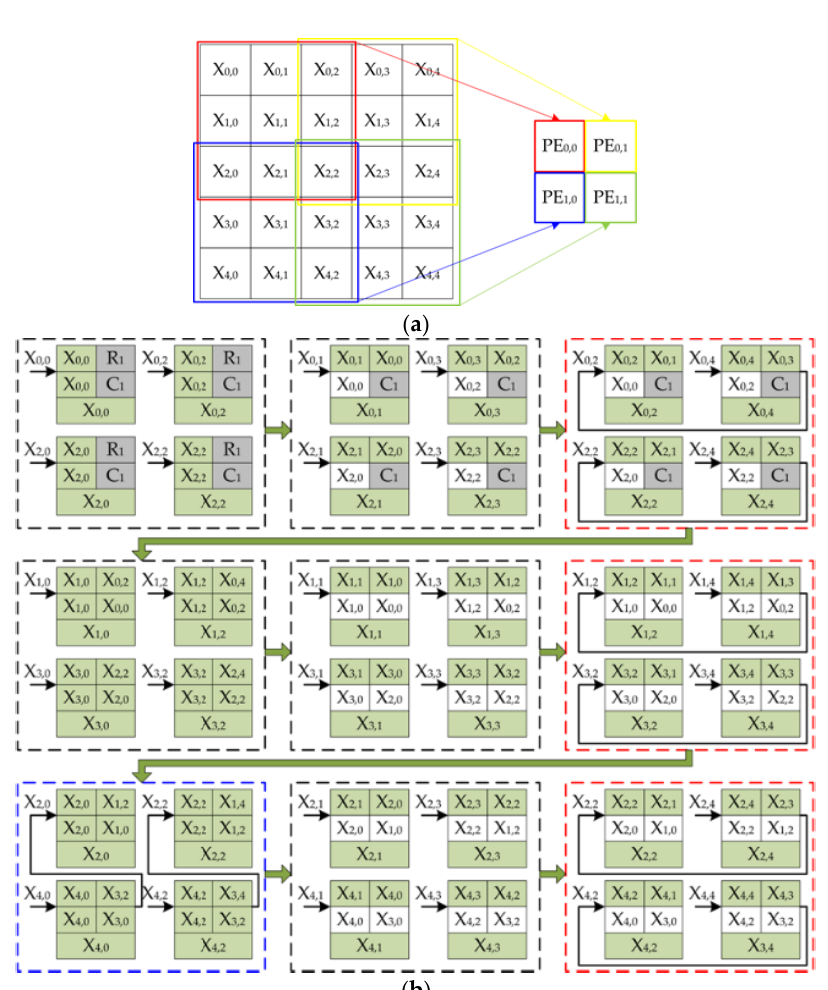
Figure 8. The neuron propagation between PEs and data reuse during the convolutional operation when stride = 2. ( a ) The mapping between neurons and PEs. ( b ) The specific operation of the PE registers and neuron propagation between PEs.